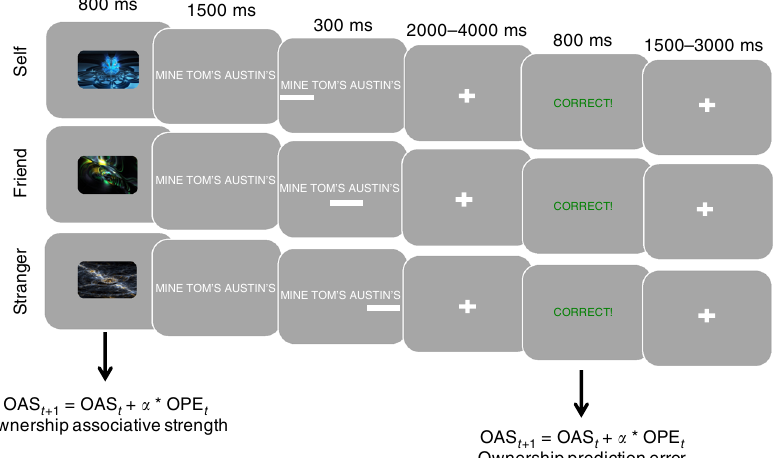
Fig. 1 Associative learning of self and other ownership. Participants performed an associative learning task where they learnt about pictures that belonged to themselves, their best friend, or to a stranger. Participants were presented with a fractal image and learnt by trial and error the ownership of the different fractals. We used an associative learning model to calculate parametric values of ownership associative strength (OAS) between picture and label at the time of the picture (the strength of ownership) and the size of the ownership prediction error (OPE) at the time of the outcome. Each fractal image was presented ten times in a pseudorandom order. There were eight pictures per each agent presented over two blocks to encourage learning while minimizing working memory